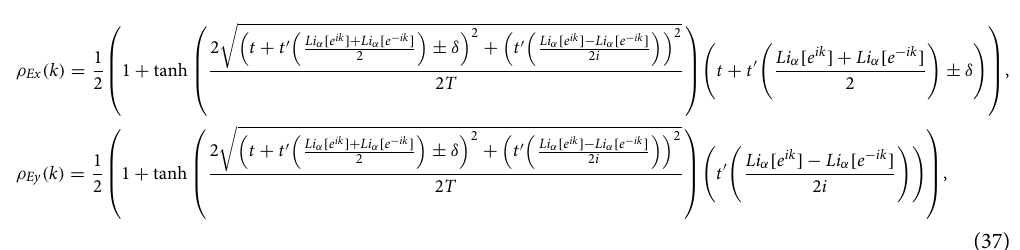
0.1 (using Eq. (37)) =